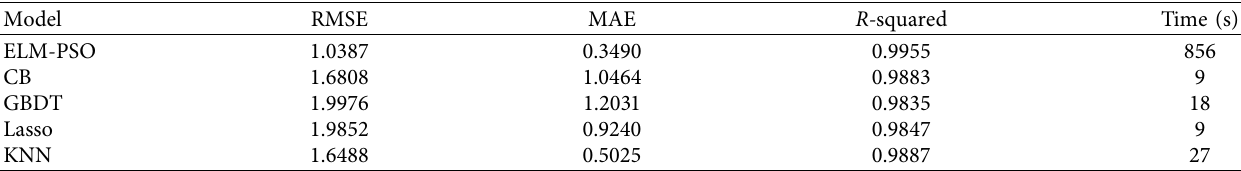
Table 3: Prediction errors on each model’s test set for the W-G HSR line.